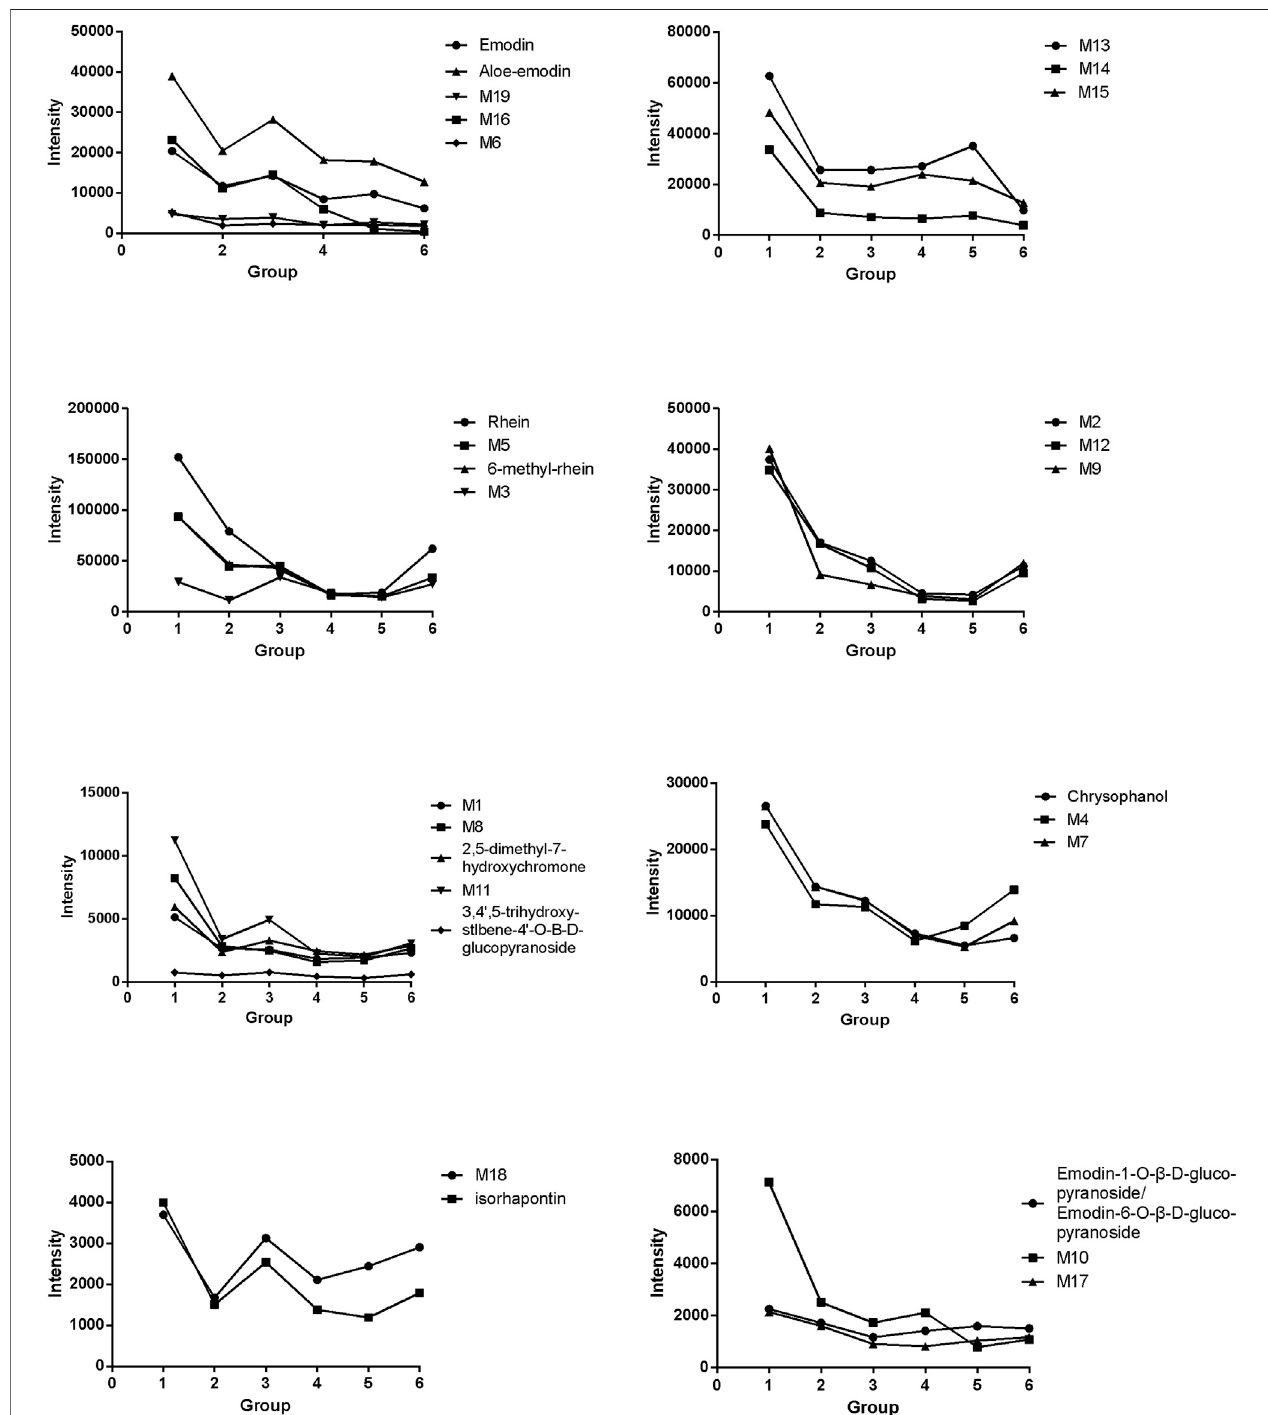
FIGURE 5 | Intensity changes in compounds absorbed into the plasma of rats with noxious heat blood stasis syndrome after administration of prepared rhubarb decoction.